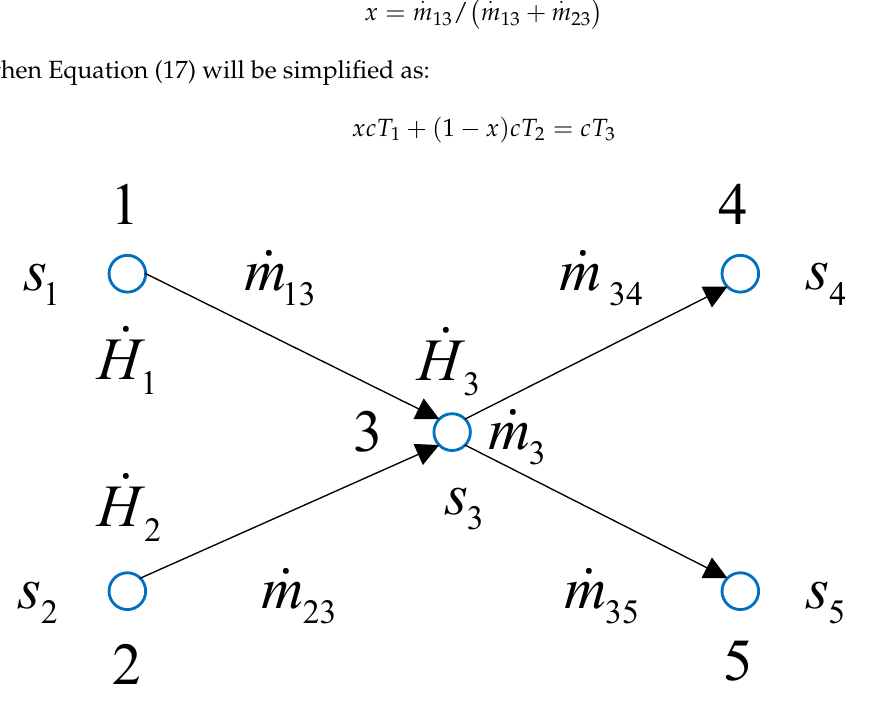
Figure 1. Schematic diagram of heating supply network node distribution.